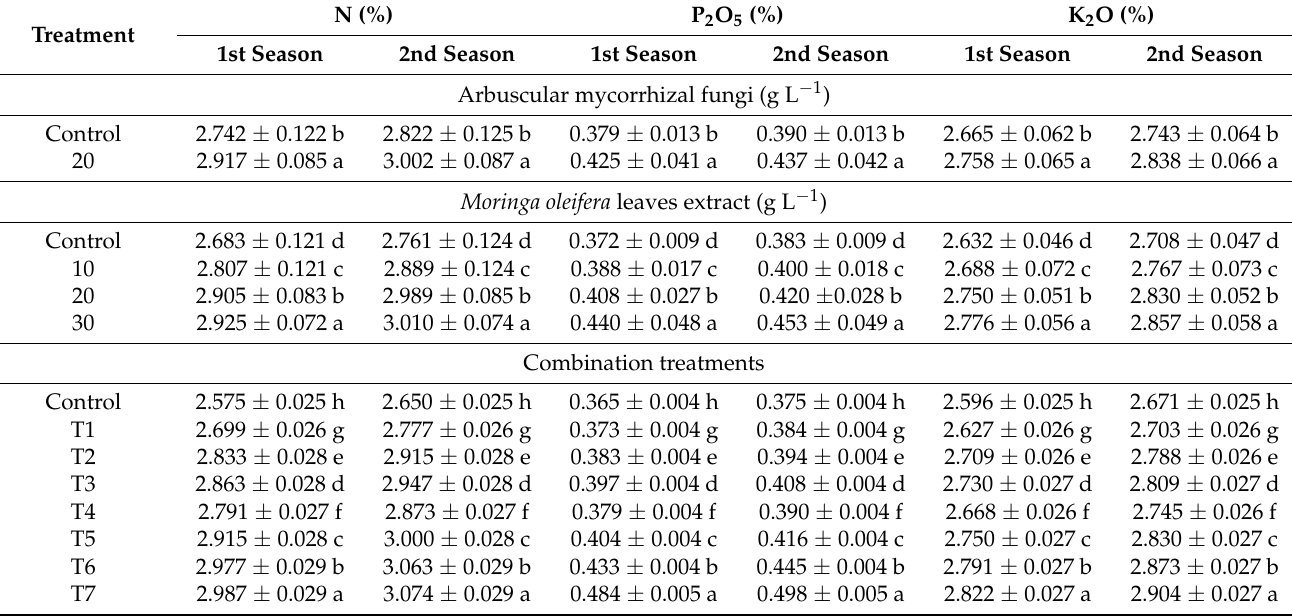
Data are mean value ± SE. Means in columns followed by the same letter are not statistically different at the 0.05 significance